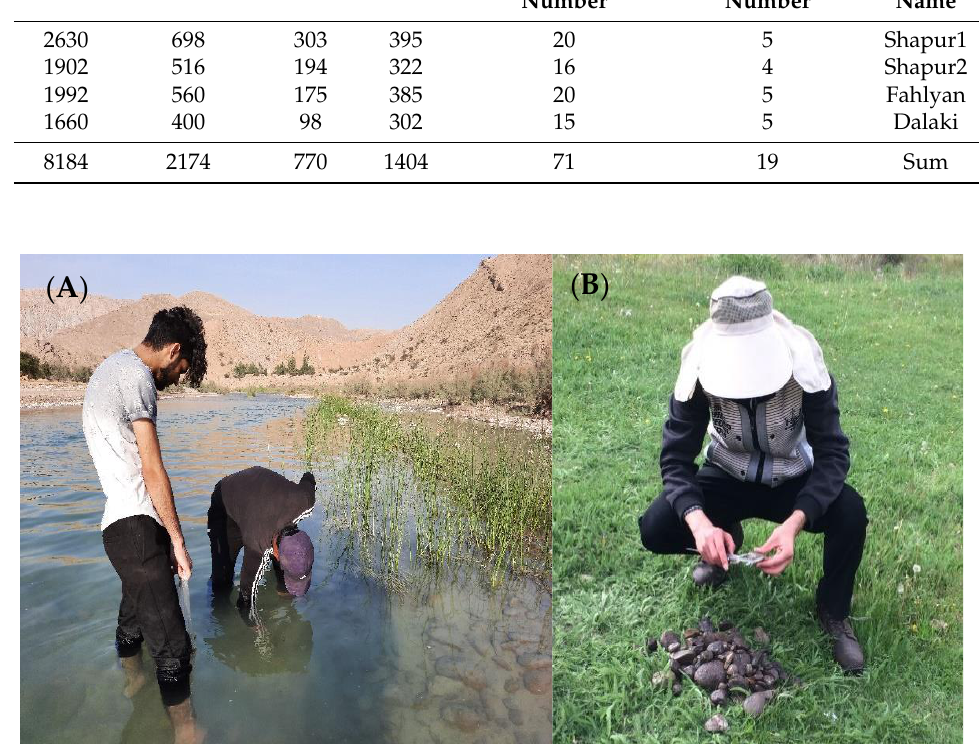
Figure 5. Plan of the studied reaches along with the position of the measured profiles.